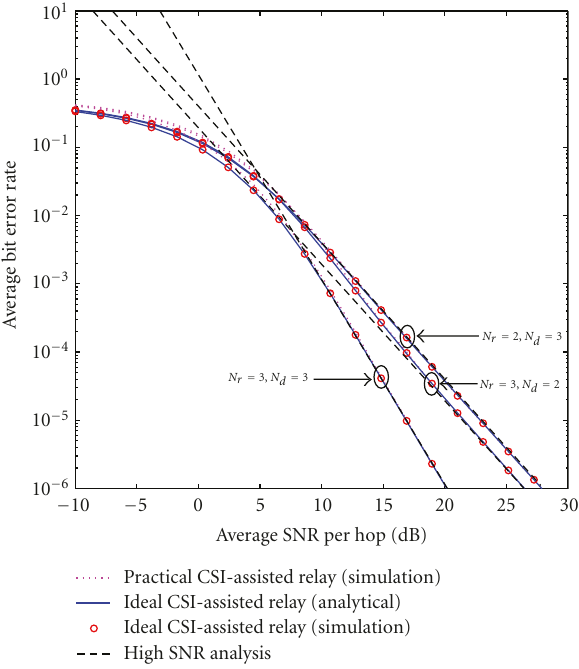
Figure 10: Average BER of dual-hop MIMO relaying over Rayleigh fading channels with uncorrelated antennas at the relay and correlated antennas at the destination. γ = π/ 6. l d = 0 . 6, and σ 2 d